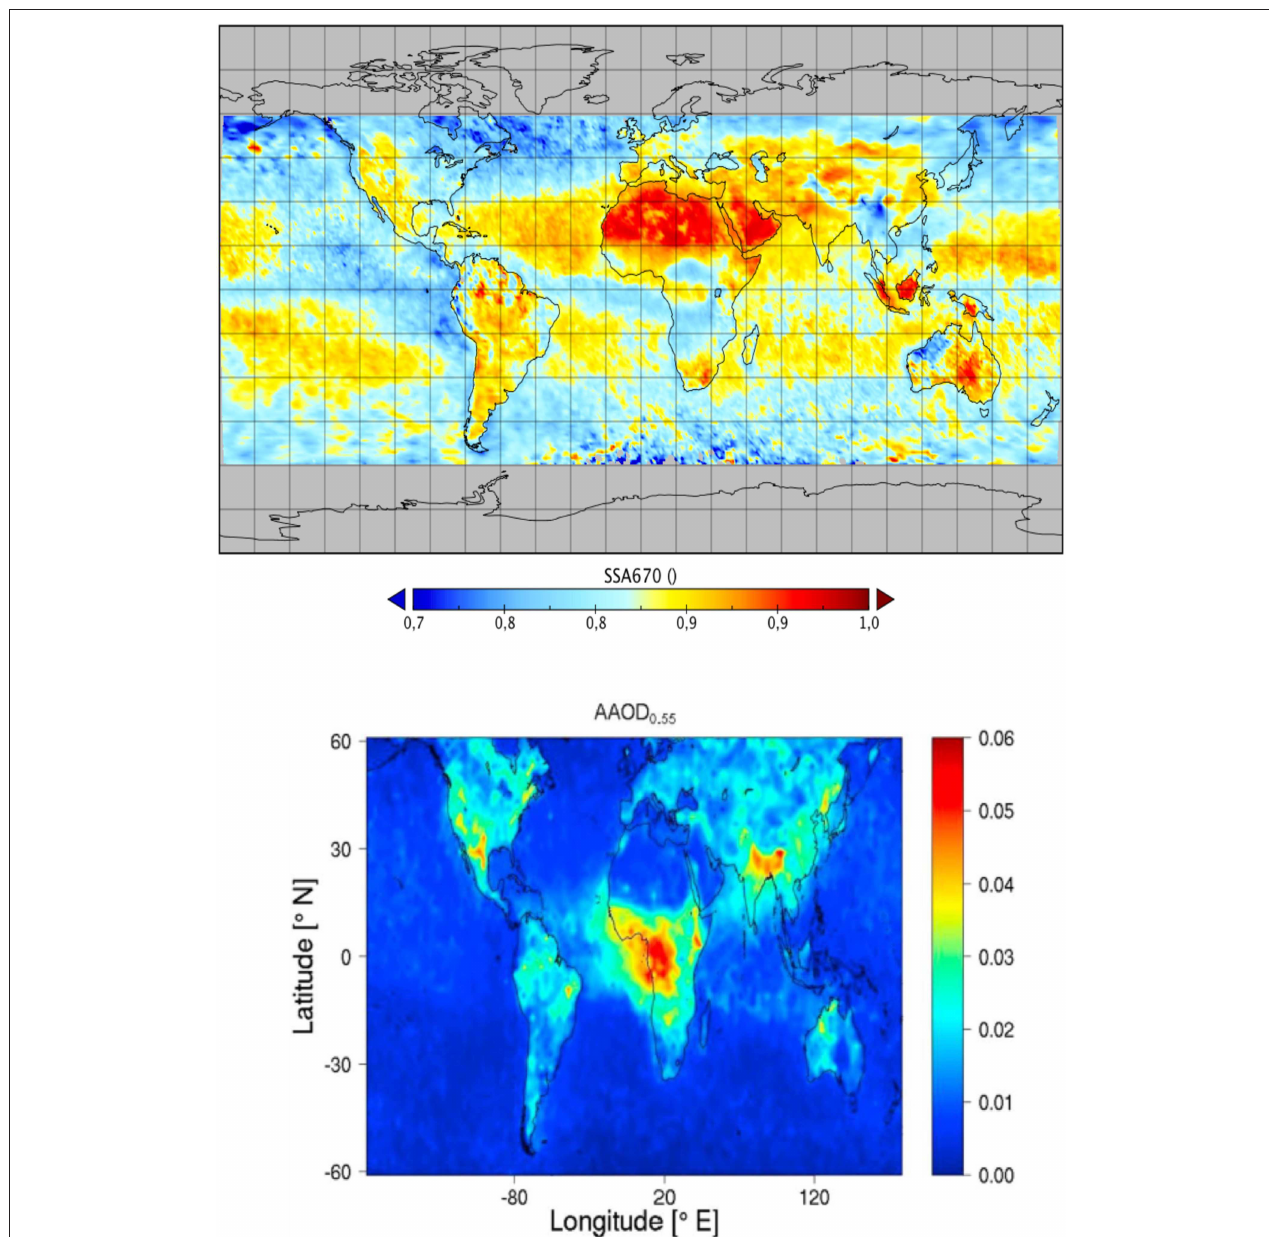
FIGURE 2 | Annual mean aerosol absorption properties for 2006 derived from PODER-3/PARASOL observations using the GRASP algorithm reporting single scattering albedo (SSA) at 670nm (Top) and using the SRON retrieval algorithm (Hasekamp et al., 2011; Fu and Hasekamp, 2018) reporting absorbing aerosol optical depth (AAOD) at 550nm (Bottom) . Adapted with permission from Lacagnina et al. (2017), John Wiley & Sons. Note that SSA is an intrinsic aerosol property while AAOD is dependent also on the aerosol loading. Direct comparisons of the two maps are not possible. However, very high AAOD should roughly correspond to low SSA, and vice-versa. Also, please note that the GRASP results are still preliminary and may be affected by cloud, snow/ice, surface heterogeneity, and other contamination